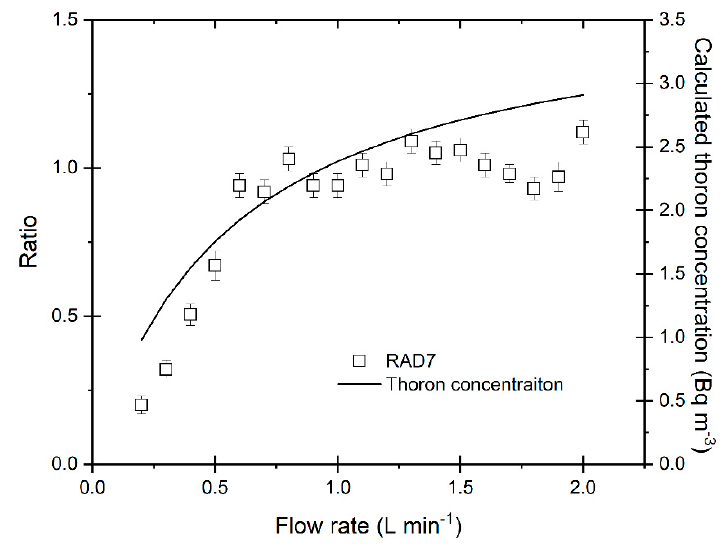
Figure 5. Relationship between the calculated thoron concentration and the ratio with flow rate.